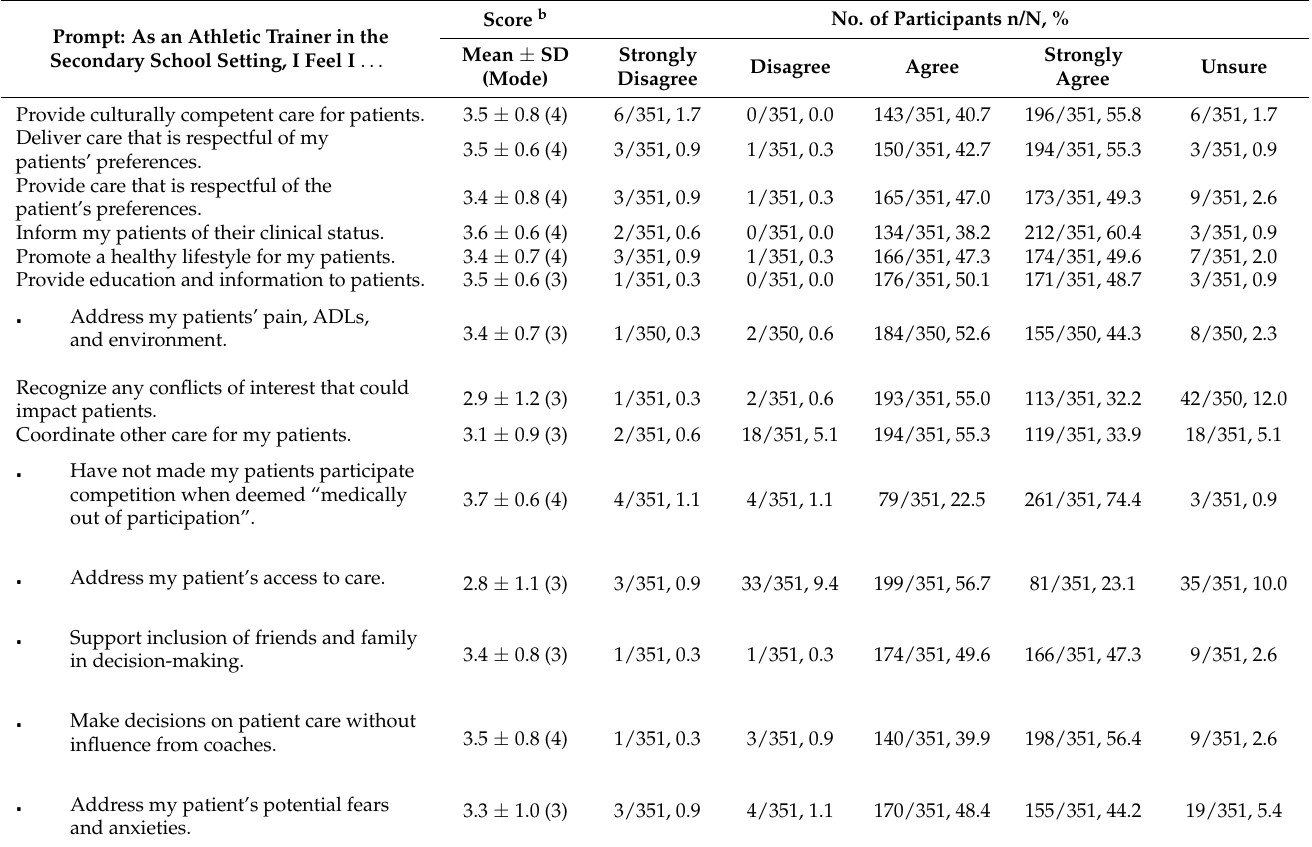
Table 3. Global Perceptions of Athletic Trainer Patient-Centered Care Tool Items and Responses a